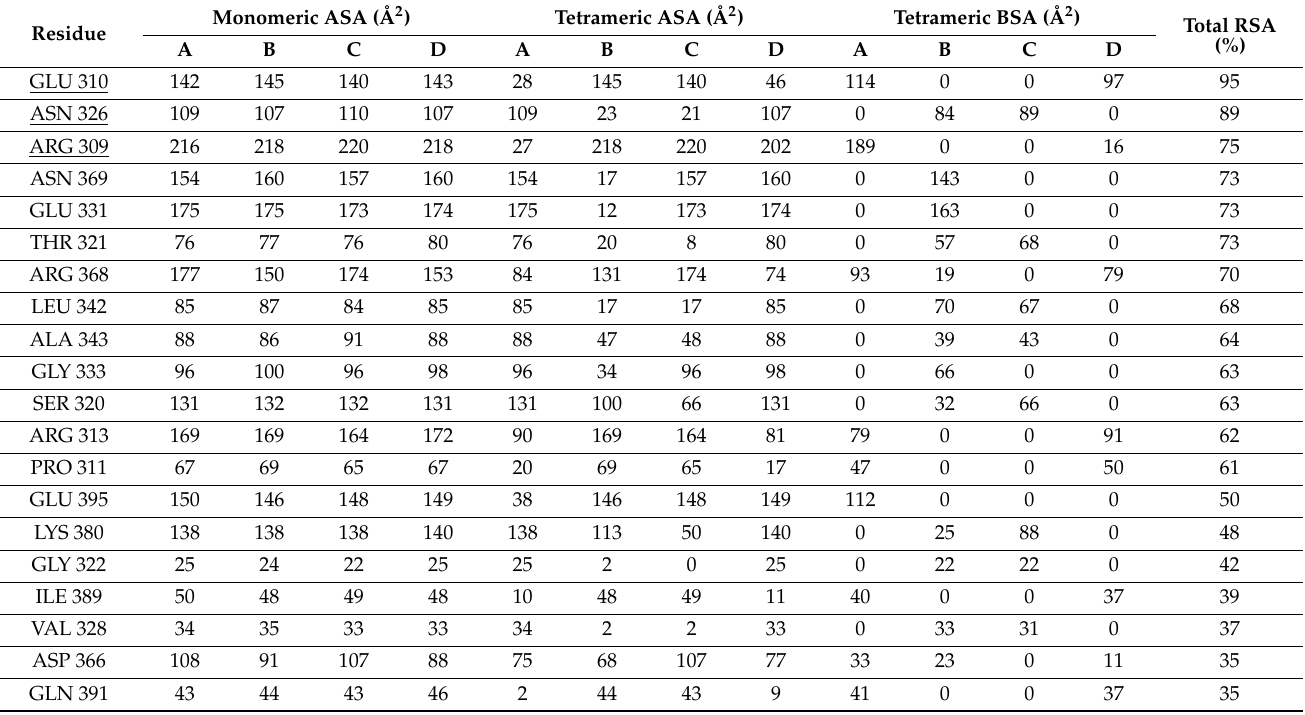
Table 1. ASA, BSA, and total RSA of candidate residues of